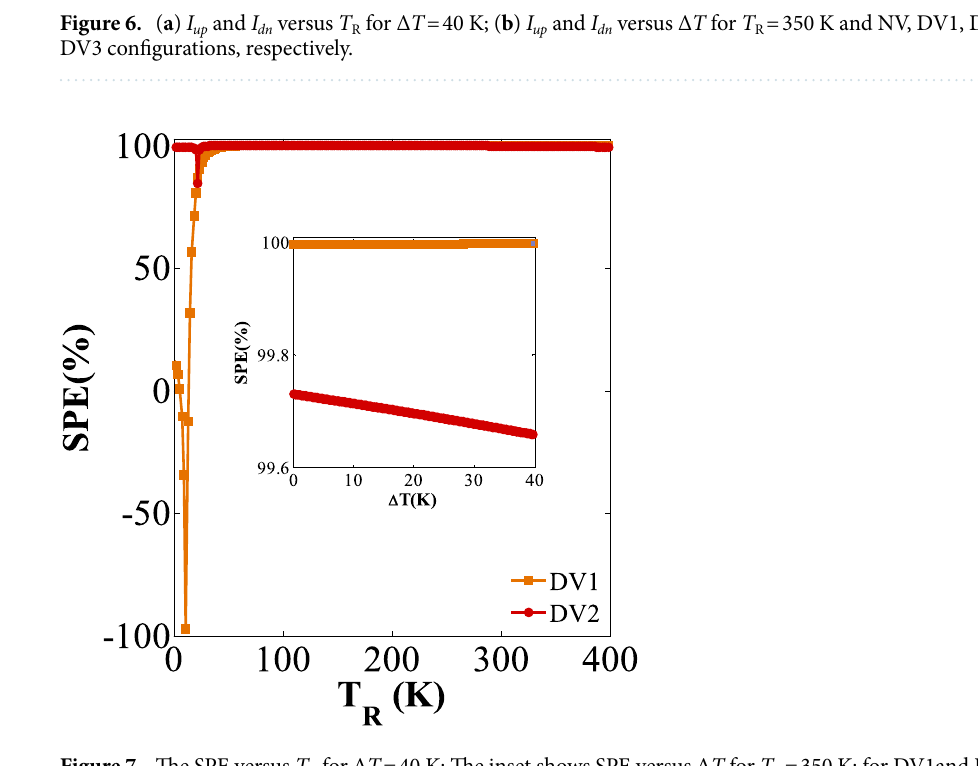
Figure 7. The SPE versus T R for ∆ T = 40 K; The inset shows SPE versus ∆ T for T R = 350 K; for DV1and DV2 configurations,